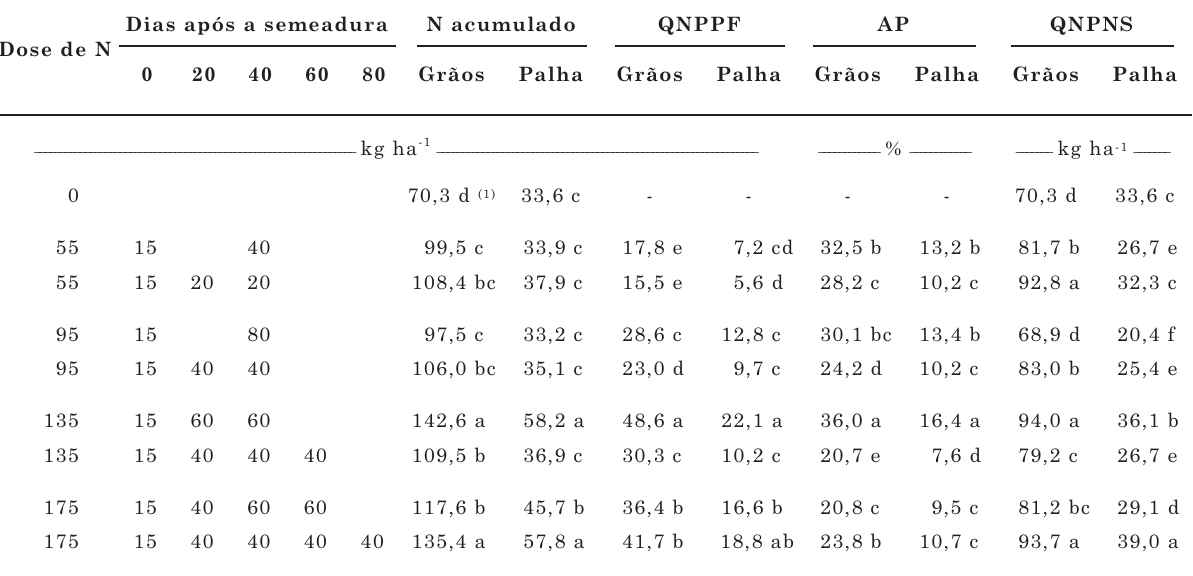
Quadro 4. Quantidade de N acumulada, quantidade de N na planta de milho proveniente do fertilizante (QNPPF), aproveitamento pelo milho do N do fertilizante (AP) e quantidade de N no milho nativo do solo (QNPNS), em função de parcelamento de diferentes doses de